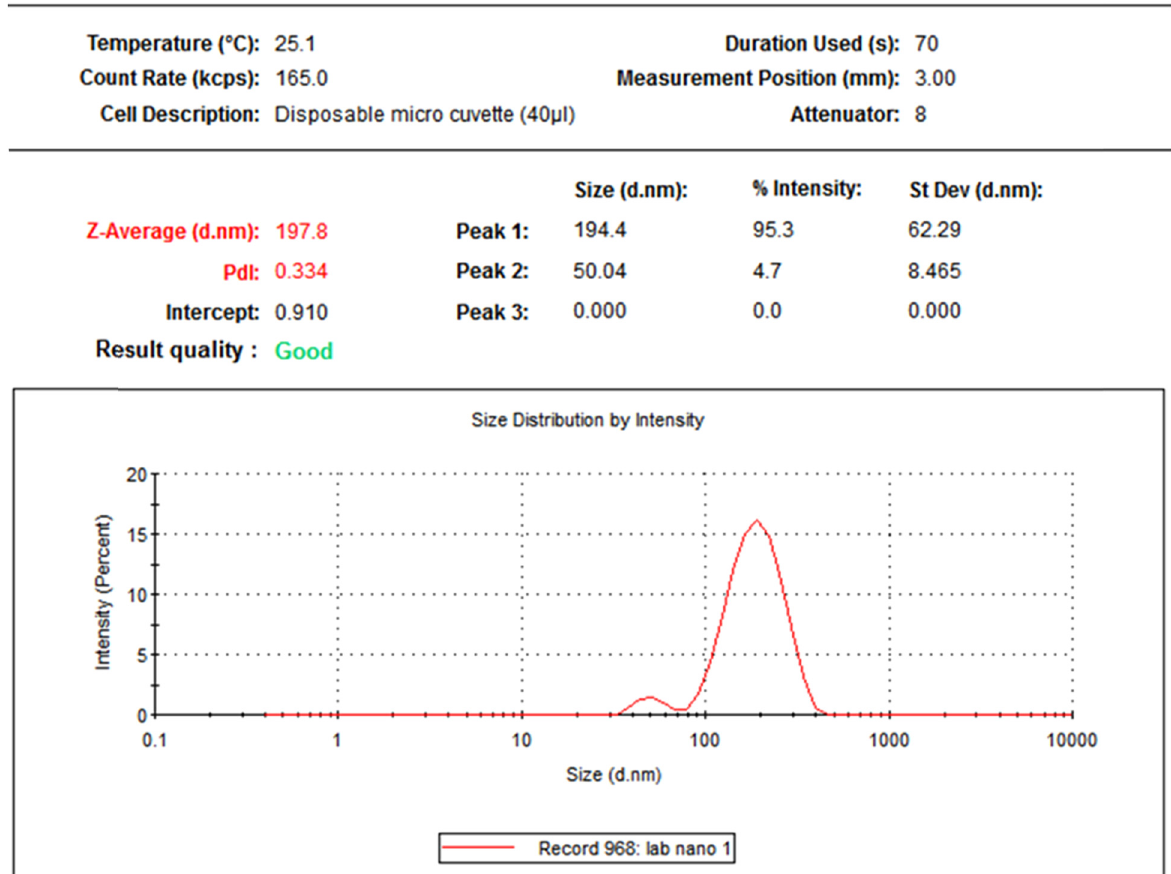
Figure 2: DLS result for the green - synthesized M. oleifera –